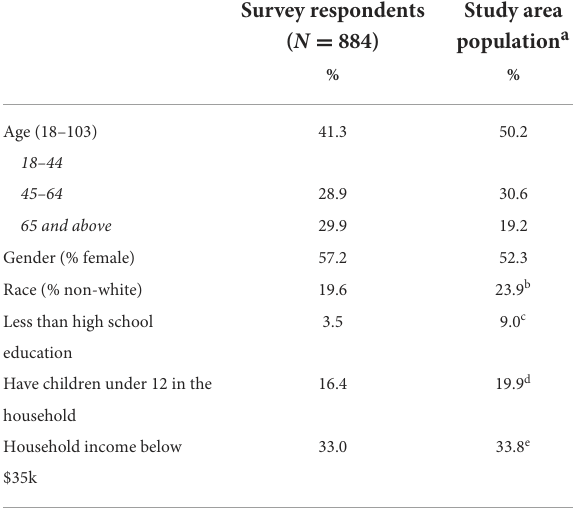
TABLE 2 Respondents to our mail survey compared with the study area population.